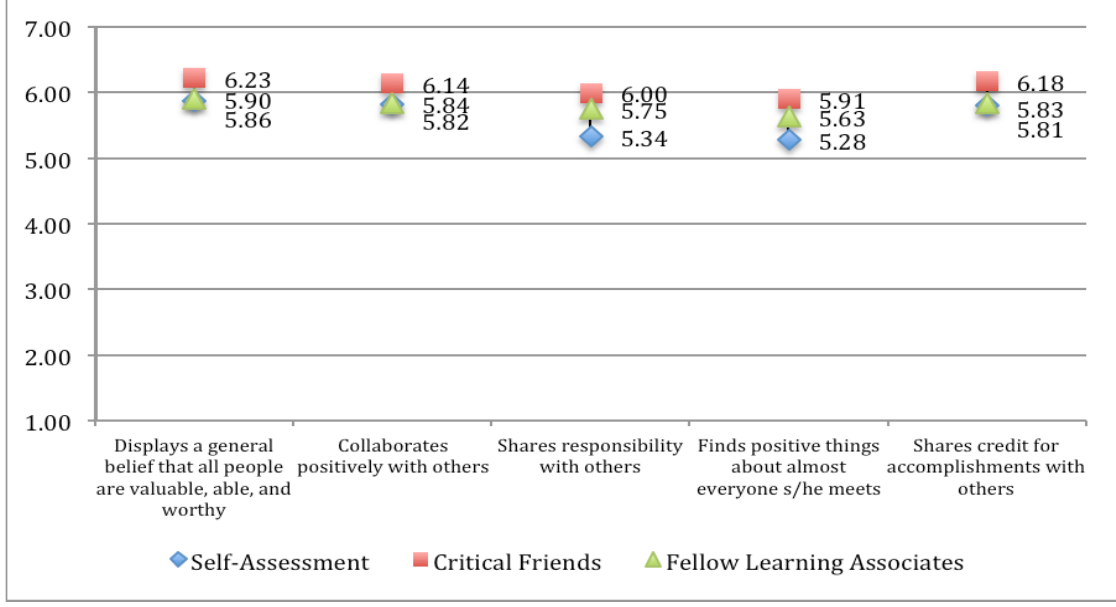
Figure 5. Perceptions of Others. Self-Assessment N=74, Critical Friends N=573, Fellow Learning Associates